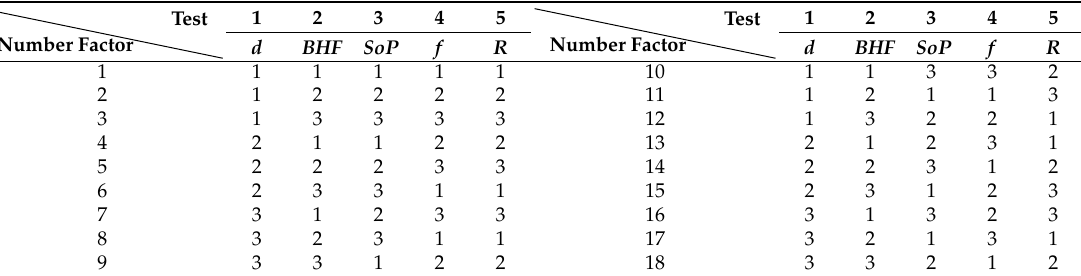
Table 7. L 18 (3 7 ) orthogonal array scheme of the optimization.